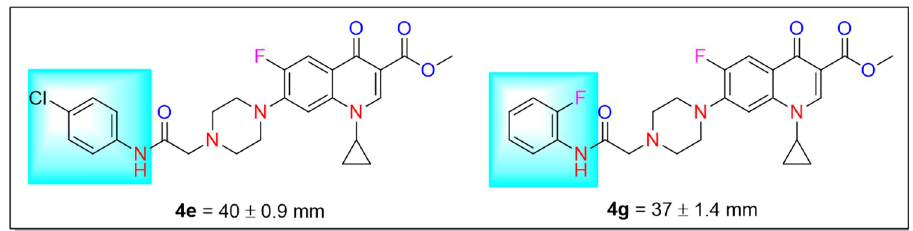
Fig 3. Structures of compounds 4e and 4g active against Bacillus subtilis .